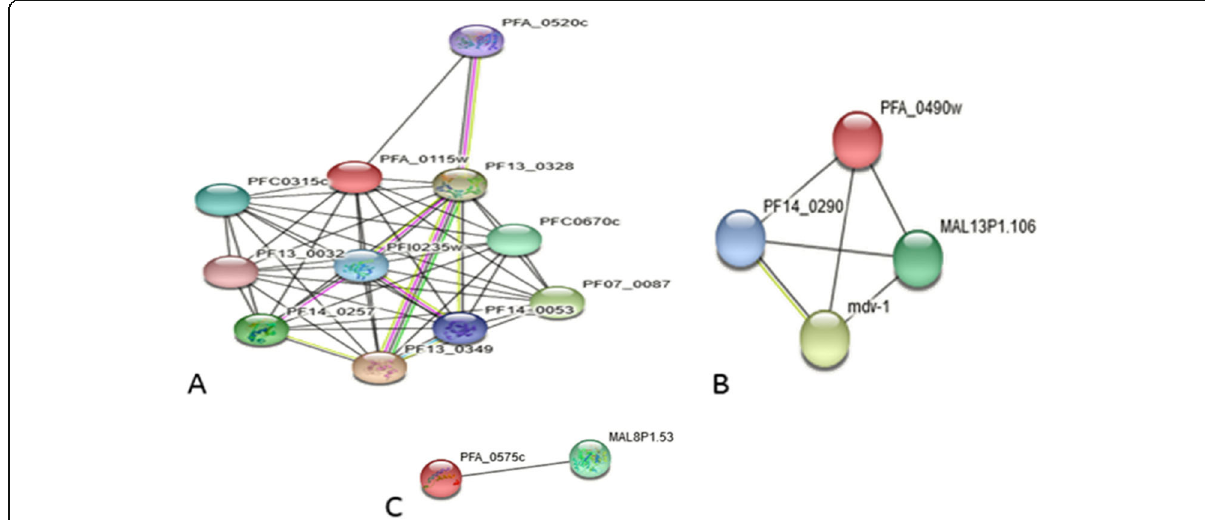
Fig. 2 Protein – protein interaction network of three hypothetical proteins of Plasmodium falciparum generated by STRING web server. A XP_001350955. B XP_001351030. C XP_001351047.1